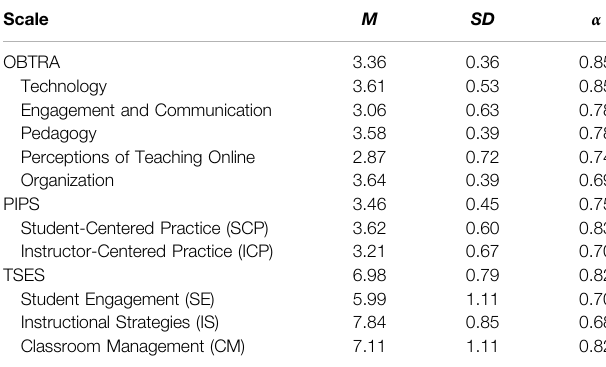
TABLE 3 | Descriptive statistics for the Online and Blended Teaching Readiness Assessment (OBTRA), Post-secondary Instructional Practices Survey (PIPS), and Teacher Self-Ef fi cacy Scale